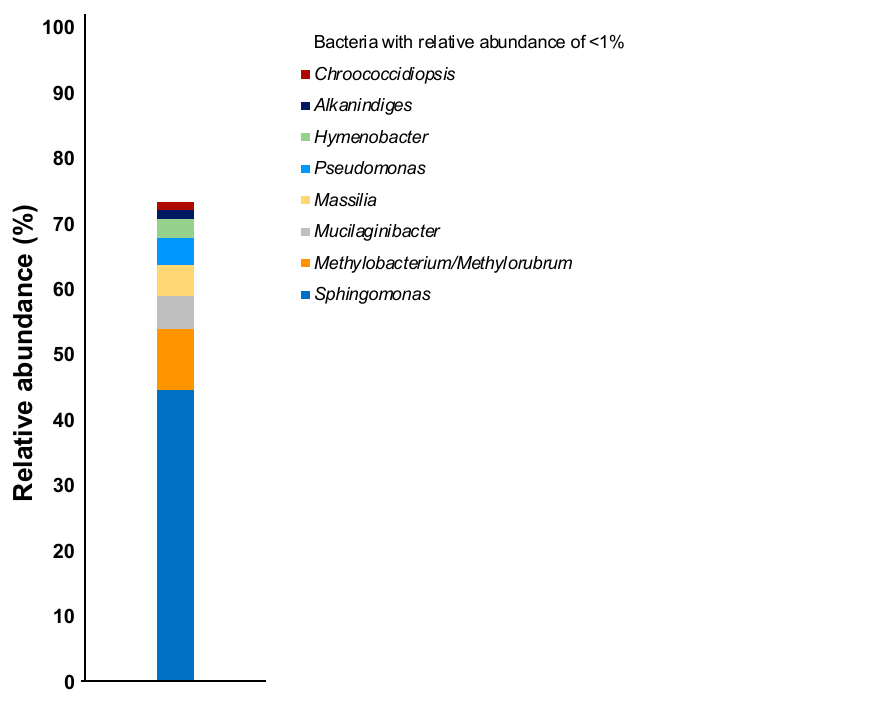
Figure 1. Relative abundances of the bacterial communities in the culture sample at the genus level.